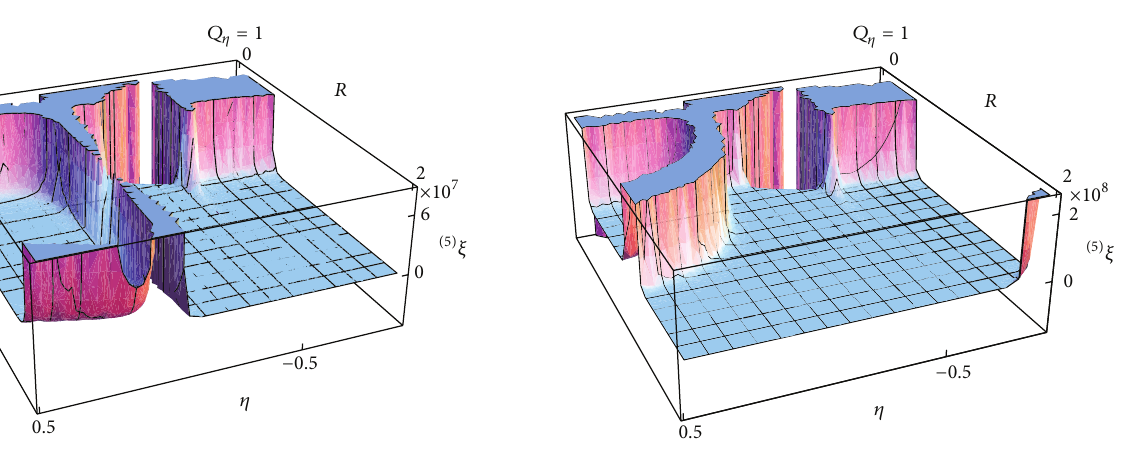
Figure 10: 5D Kretschmann invariant (5) 𝜉 for 𝑄 𝜂 = 1 , for Λ = 1 .